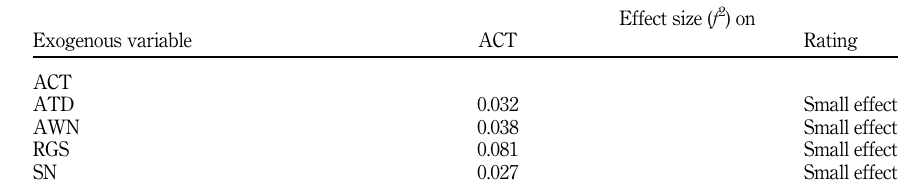
Table 5. f 2 of factors